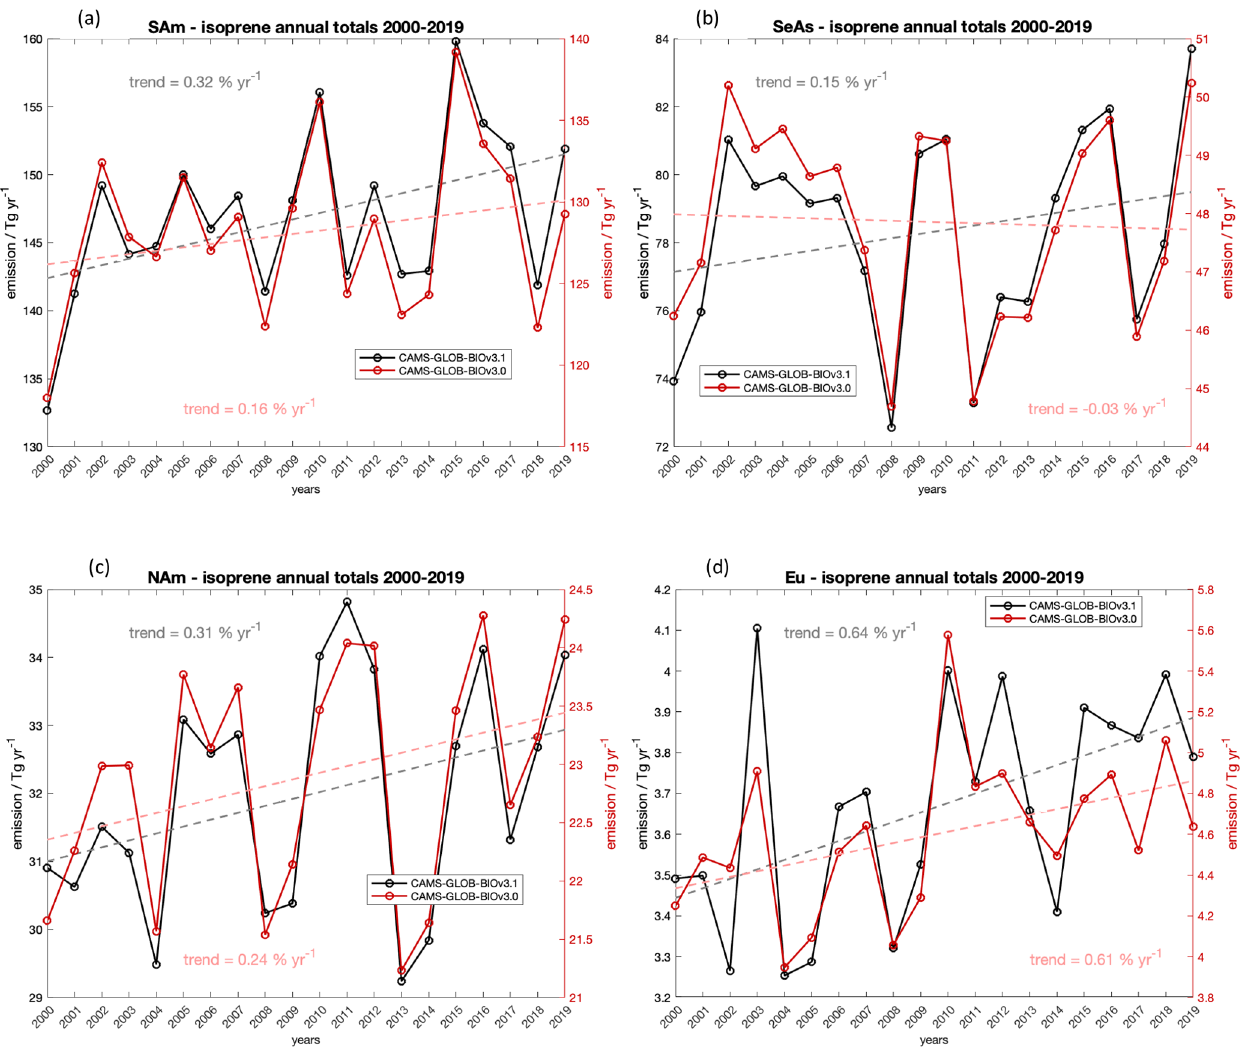
Figure 4. Comparison of isoprene annual totals from CAMS-GLOB-BIOv3.0 and v3.1 in (a) South America, (b) Southeast Asia and Indonesia, (c) North America, and (d) Europe with linear trend for each dataset (dashed line and trend value in %yr − 1 ).